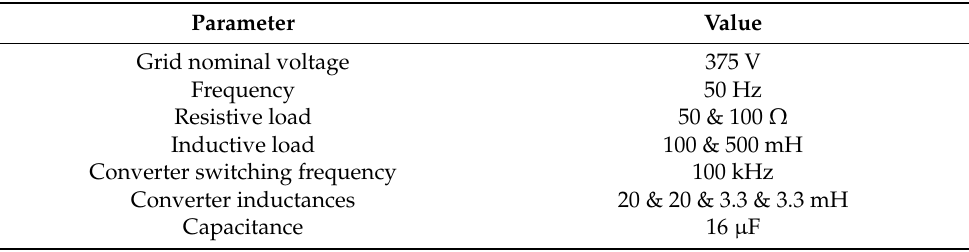
Table 1. System parameters.